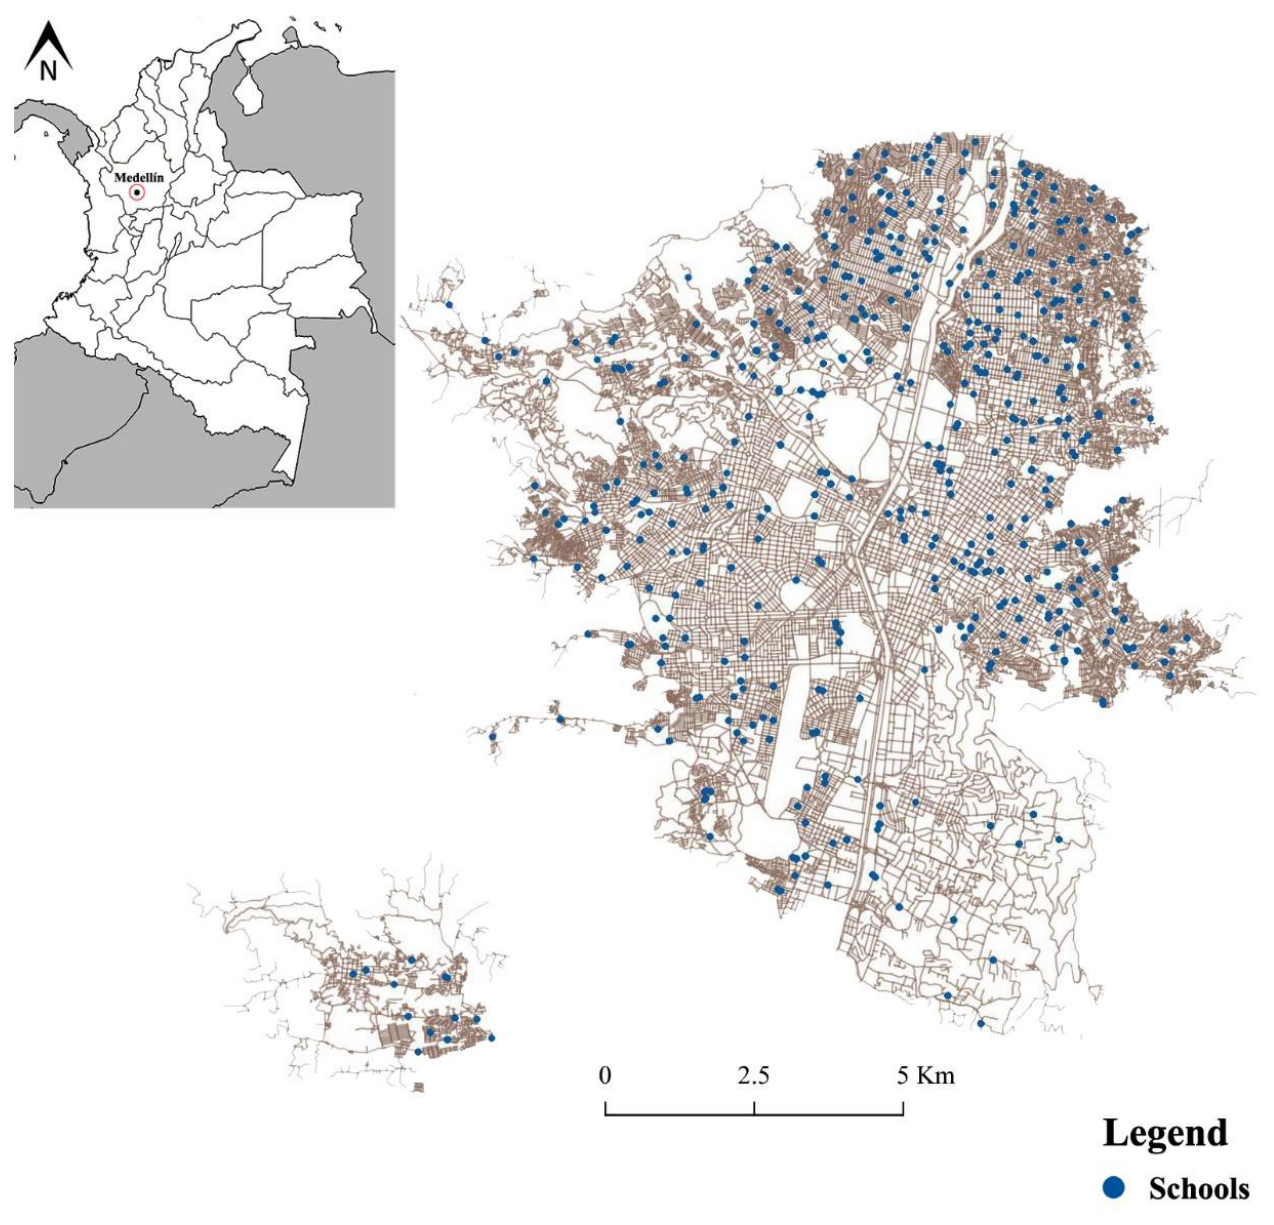
Figure 1. Location of schools in Medellín, Colombia included in this study. The presence and number of potential larval development sites (water-holding con- tainers), such as tires, flower vessels, bottles, trash cans, or gutters, within each school was recorded. All containers and schools were visually assessed for the presence of immature forms and adults to calculate the following traditional Aedes indices: Adult Index (AI) (the percentage of schools infested with adults Aedes ), house index (HI) (the percentage of schools infested with larvae and/or pupae), container index (CI) (the percentage of water- holding containers infested with larvae or pupae), and Breteau index (BI) (the number of positive containers per 100 schools inspected). Containers were counted as positive if they had immature forms of the vector, whereas schools were considered positive if at least one container with immature forms of Aedes spp. During 2016, schools were inspected once per trimester, and in 2017 and 2018 schools were visited once a month. We aggregated ento-virological data to a three-month scale to enable comparison to entomological